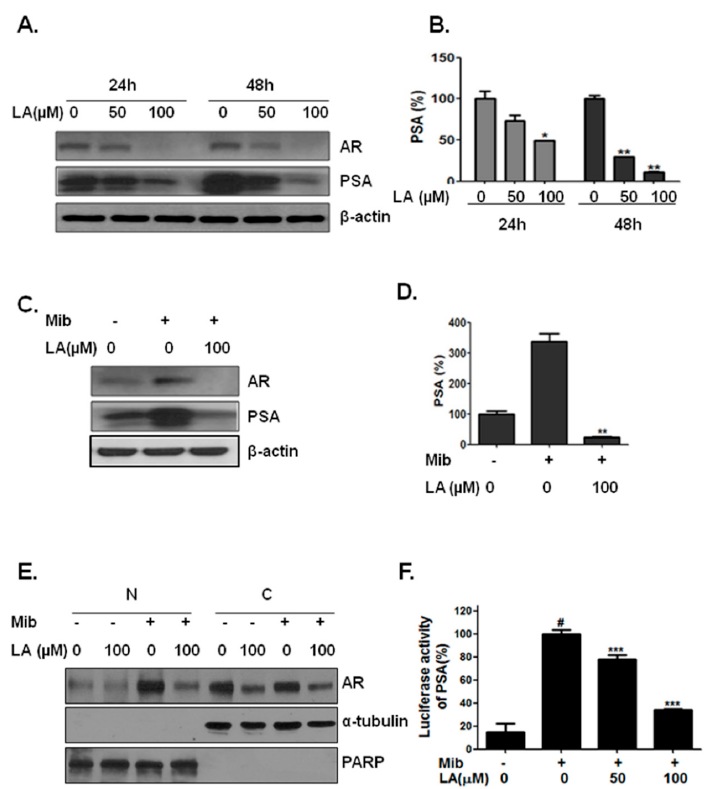
Figure 3. Concentration-dependent inhibition of PSA and AR and the time course of inhibition of PSA and AR by LA. ( A ) Western blot analysis of cellular prostate-specific antigen (PSA) and androgen receptor (AR) following the treatment of LNCaP cells with LA for 24 and 48 h; ( B ) ELISA measurement of secreted PSA after 24 h. * p < 0.05 and ** p < 0.01 (in comparison to the control); ( C ) LNCaP cells were seeded in phenol red-free medium supplemented with 5% charcoal-stripped serum. Western blot analyses of cellular PSA and AR following treatment with LA, with or without mibolerone (Mib); ( D ) LNCaP cells were seeded in phenol red-free medium supplemented with 5% charcoal-stripped serum. ELISA of secreted PSA measured following treatment with LA, with or without Mib. ** p < 0.01 (in comparison to the control); ( E ) LNCaP cells were seeded in phenol red-free medium supplemented with 5% charcoal-stripped serum in a T25 plate. Cells were treated with LA (0 and 100 µ M) and Mib (1 nM). LNCaP cells were harvested and then separated into nuclear and cytosolic fractions using the NE-PER Nuclear and Cytoplasmic Extraction Reagent kit (Thermo Scientific, Waltham, MA, USA), and then, the specificity of separation was confirmed using Western blotting for total poly-ADP-ribose polymerase (PARP) and α -tubulin as respective nuclear and cytosolic markers; ( F ) LNCaP cells were seeded in phenol red-free medium supplemented with 5% charcoal-stripped serum in culture plates and then transfected with luciferase reporter plasmids combined with the PSA-Luc reporter for 24 h. Cells were treated with LA (0, 50 nd 100 µ M) or mibolerone (Mib, 1 nM) and lysed, and then reporter activity was analyzed using the Luciferase Reporter Assay system (Promega, Madison, AL, USA). # p < 0.05 (in comparison to the untreated control) and *** p < 0.001 (in comparison to